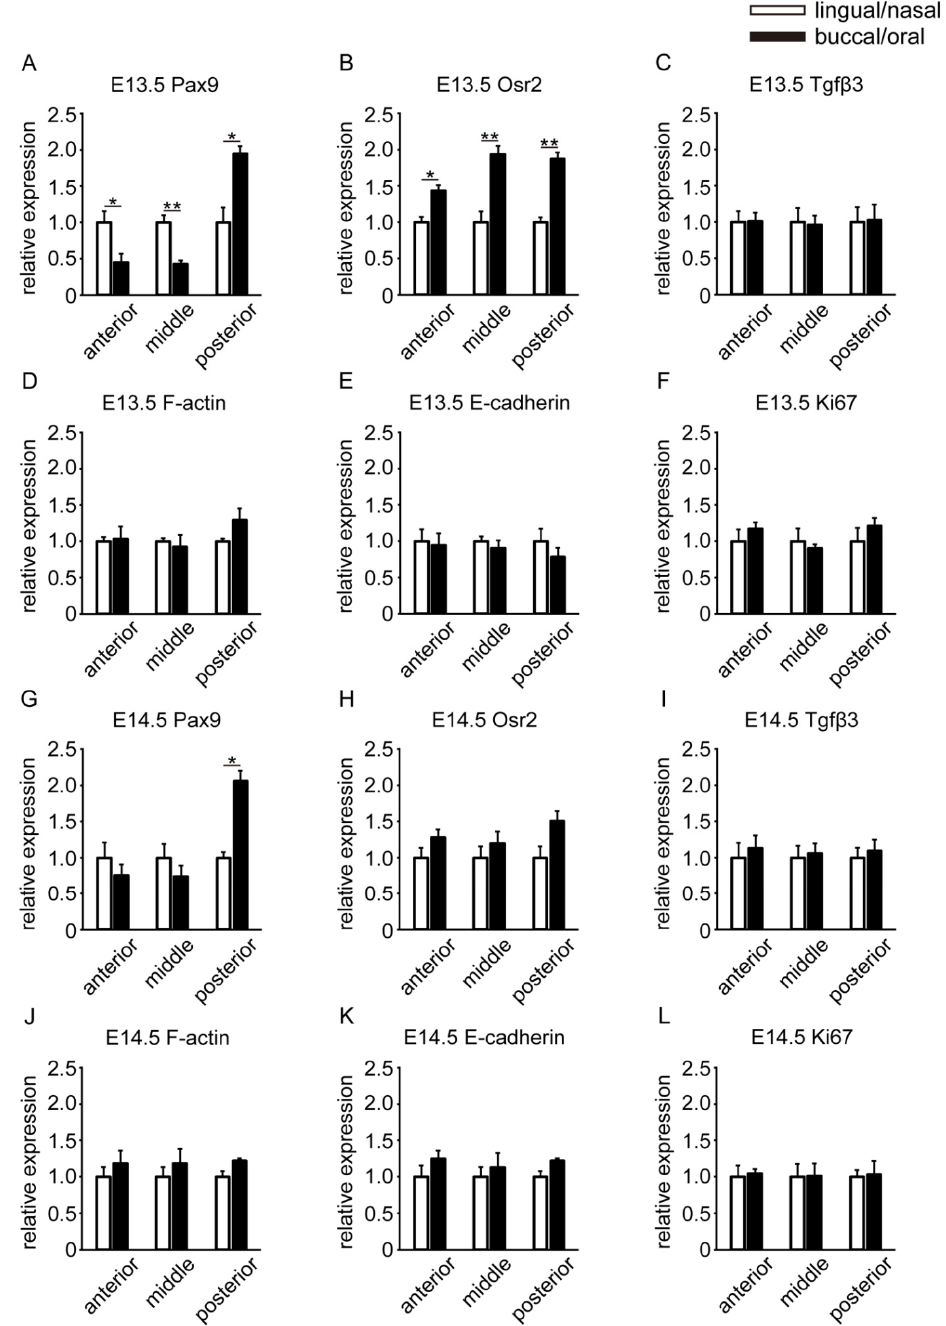
Figure 4. Spatial differences in anterior-to-posterior parts of the palatal shelf in both ( A – F ) E13.5 and ( G – L ) E14.5 through an RT–PCR assay. The results are expressed as the fold change in gene expression compared to lingual/nasal regions as a control and are presented as the mean ± SEM ( n = 5). Student’s t -test was used to analyze the difference. * p < 0.05 and ** p < 0.01 were considered statistically